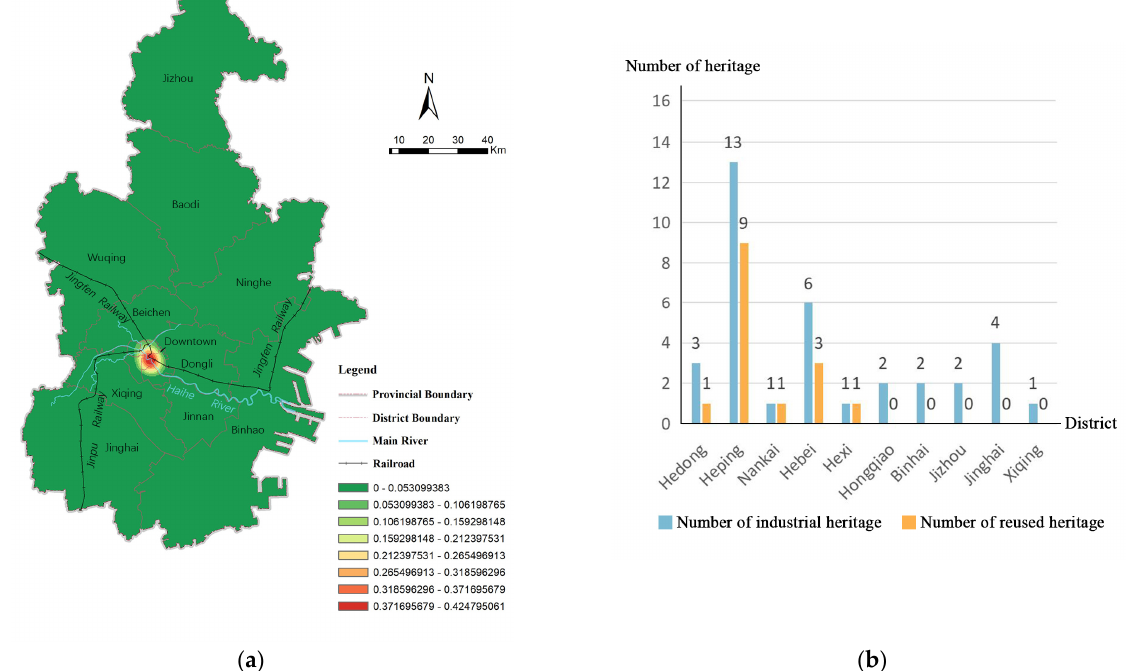
Figure 11. ( a ) Analysis of the kernel density of building-type industrial heritage in Tianjin; ( b ) sta- tistics on the total amount of building-type industrial heritage and the amount of its reuse in Tianjin by